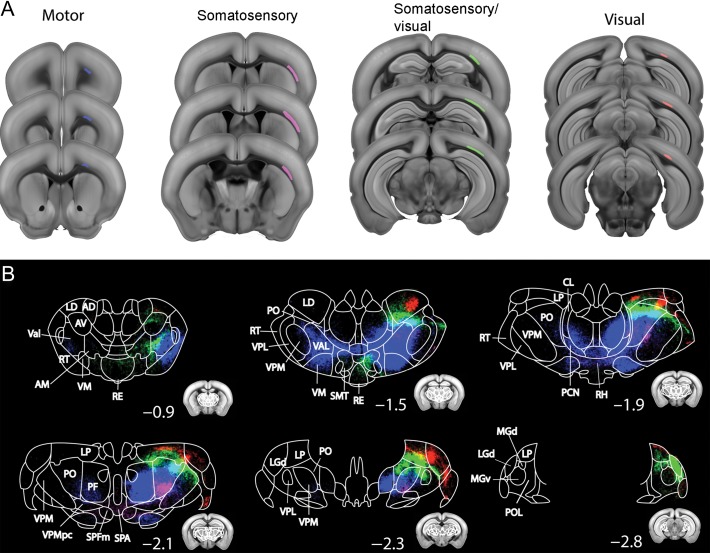
Projections from Drd1a-Cre+ layer 6b neurons from motor (MO), somatosensory (SS), SS/visual (SS/VIS), and visual (VIS) cortex target distinct regions of thalamus. Cortico-thalamic projections of Drd1-Cre from somatosensory and visual cortices using Cre-dependent AAV-eGFP tracing. (A) AAV infected areas targeting MO (blue), SS (magenta), SS/VIS (green) and VIS (red) cortex. (B) Thalamic projectome derived from the 4 cortical areas pseudo-colored with different colors matching the injection site (A). Small inserts represent the outline of the coronal sections; numbers indicate distance from bregma. Note, projections from different cortical areas have topographically segregated projections to mostly higher order thalamic areas. Some projections innervate the contralateral thalamic nuclei such as rhomboid (RH), reuniens (RE), submedial (SMT) and subparafascicular nucleus (SPF) as well as subparafasciular area (SPA) of the thalamus. AD, anterodorsal nucleus; AM, anteromedial nucleus; AV, anteroventral nucleus; CL, central lateral nucleus; LD, lateral dorsal nucleus; LGd, dorsal lateral geniculate nucleus; LP, lateral posterior nucleus; MGd, dorsal medial geniculate nucleus; MGv, ventral medial geniculate nucleus; PCN, paracentral nucleus; PF, parafascicular nucleus; PO, posterior nucleus; POL, posterior limiting nucleus; RE, nucleus reuniens; RH, rhomboid nulceus; SPA, subparafascicular area; SPF, subparafascicular nucleus; RT, (pre-)thalamic reticular nucleus; SMT, submedial nucleus; Val, ventral anterior lateral complex; VM, ventral medial nucleus; VPL, ventral-posterior lateral nucleus; VPM, ventral-posterior medial nucleus.